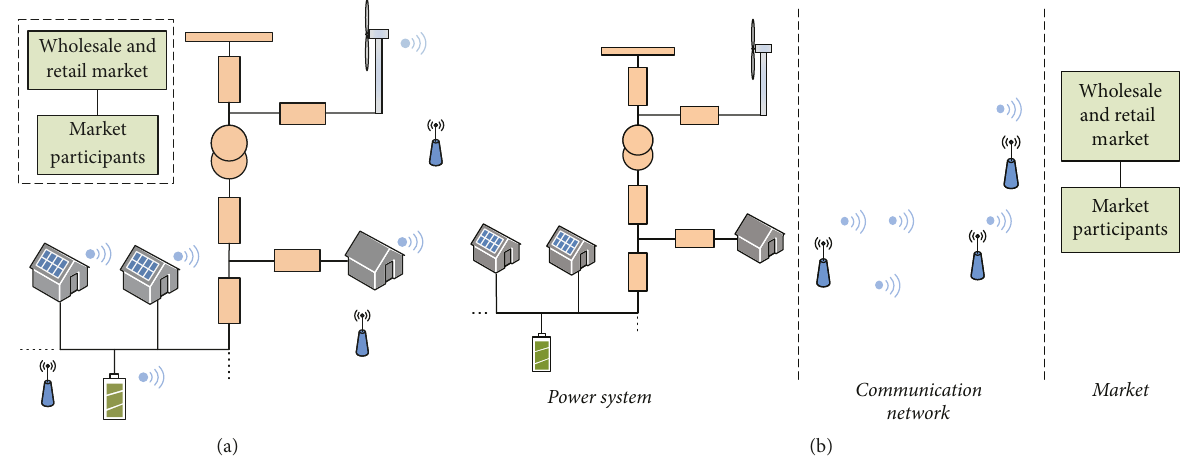
Figure 1: Exemplary topology including components of all domains (a) and domain-specific topologies